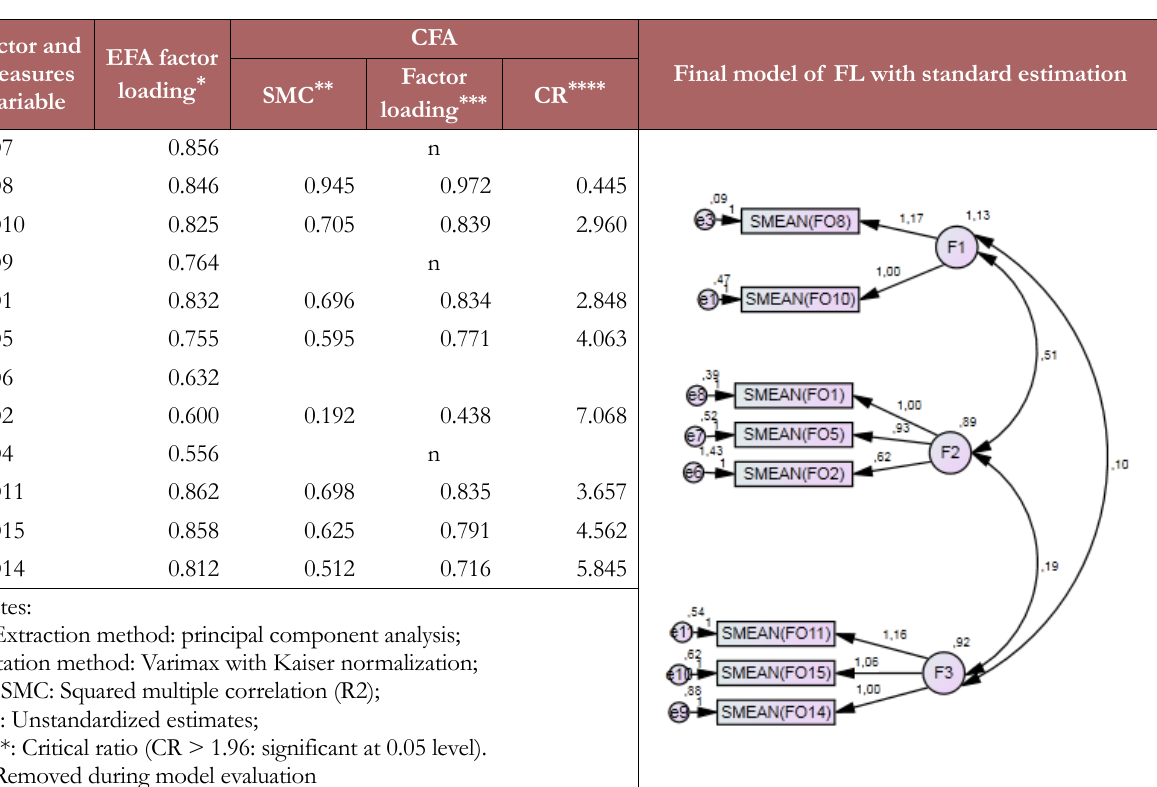
Table 18. EFA and CFA of the FO construct